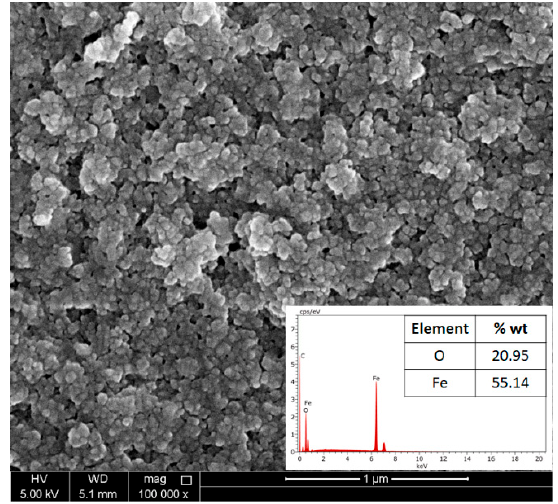
Figure 1. SEM image of the synthesized Fe 3 O 4 nanoparticles. The inset is the energy-dispersive spectroscopy (EDS) analysis.